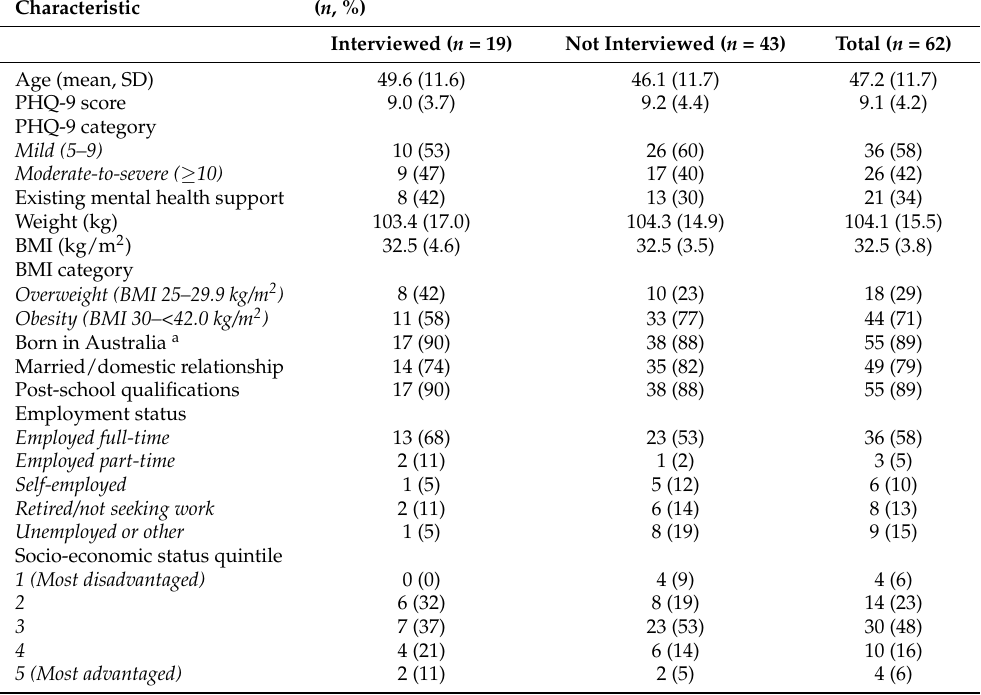
Table 2. Baseline characteristics of men from the SHED-IT: Recharge intervention group.